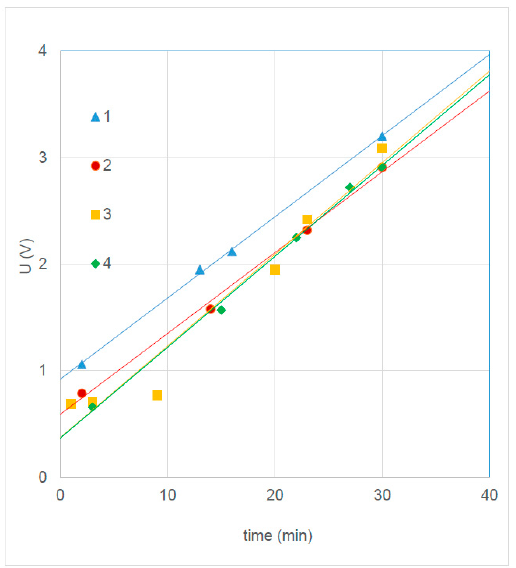
Figure 8. Anodizing potential of four silver plates; regression lines of 3 and 4 coincide.